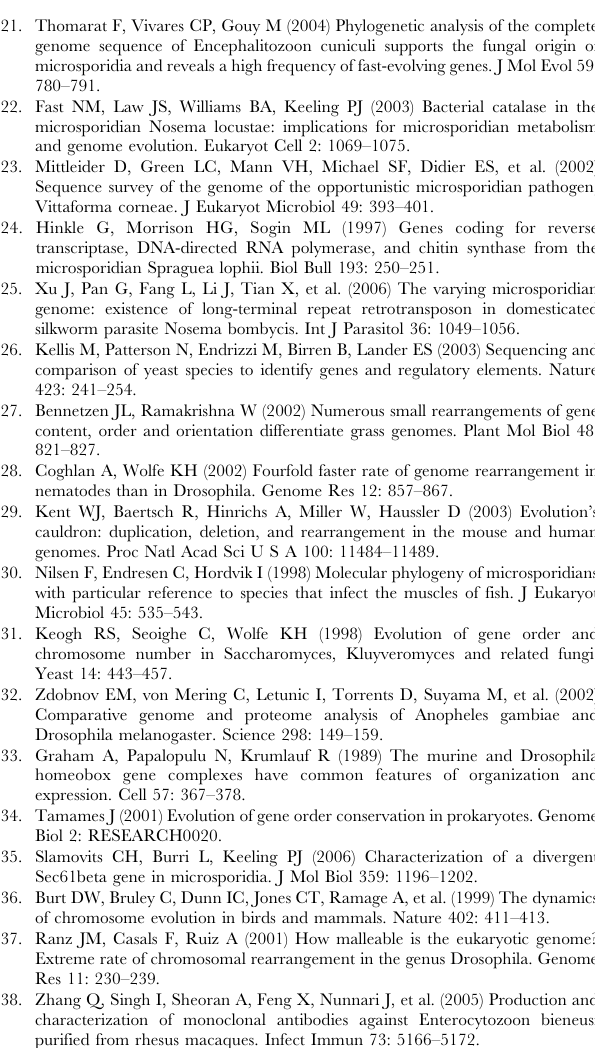
Figure S1 Examples of gene order conservation between E. cuniculi , E. bieneusi and A. locustae . This figure represent genomic regions of A. locustae previously identified by Slamovits et al. (2004) and Williams et al. (2004) numerical citations. Loci in the same order are shown in coloured arrows and are linked with straight lines. Transcriptional direction of genes is indicated by arrow direction. The accession numbers of A. locustae fragments shown in this figure are as follows. A. AY548887, B. AY548895, C.